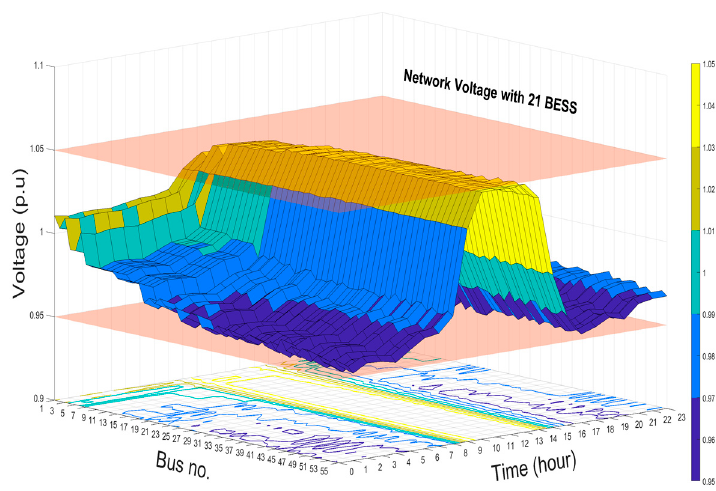
Figure 12. Network voltage profile with 17 BESS installed.